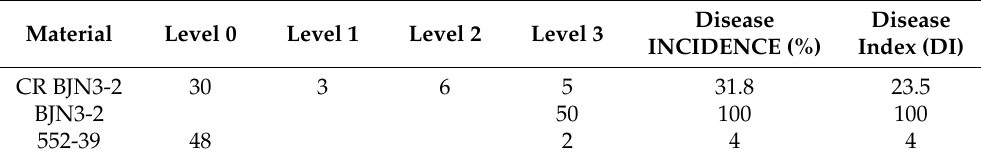
Table 3. Self-compatibility index (SCI) of the pyramided line 552-39 and two parental lines (CR BJN3-2 and KYS). Figure 7. Phenotypic investigation of locule number for the pyramided line and two parental lines. CR BJN3-2: recurrent parent; 552-39: selected pyramided line. Table 4. Agronomic trait evaluation of recurrent parent and pyramided line. Agronomic Traits